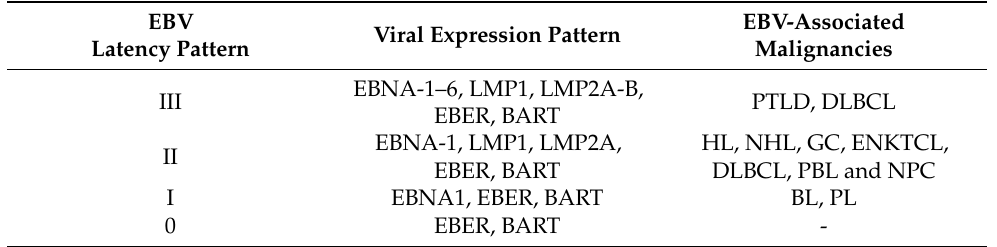
Table 1. EBV-associated malignancies and viral latency programs. EBV-associated malignancies show a particular viral latency pattern. EBV EBV-Associated Viral Expression Pattern Latency Pattern Malignancies EBNA-1–6, LMP1, LMP2A-B, III PTLD, DLBCL EBER, BART EBNA-1, LMP1, LMP2A, HL, NHL, GC, ENKTCL, II EBER, BART DLBCL, PBL and NPC I EBNA1, EBER, BART BL, PL 0 EBER, BART